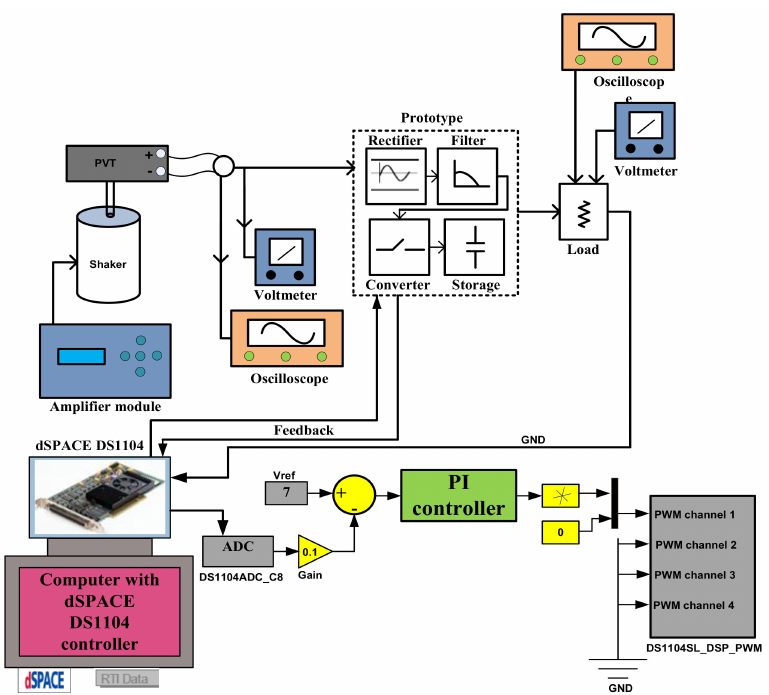
Figure 9. Block diagram of experimental test bench